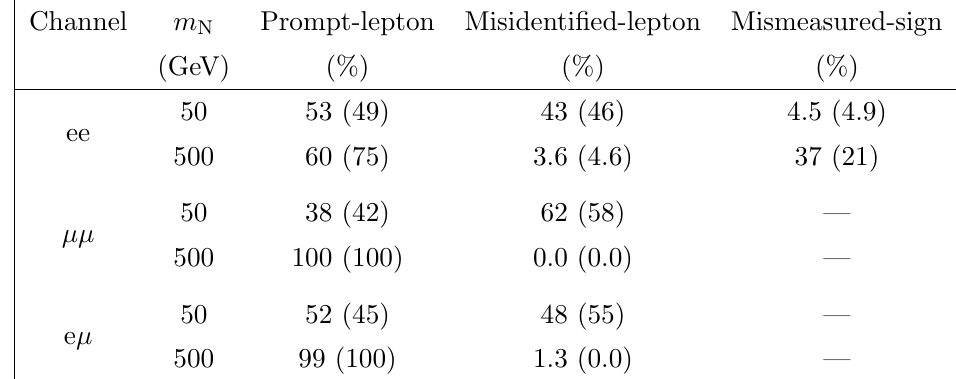
Table 3 . Fractional contributions to the total background systematic uncertainties related to the uncertainties in the prompt SS lepton, misidenti(cid:12)ed-lepton, and mismeasured-sign background. The numbers are for the SR1 (SR2) in the case of m N = 50 and 500 GeV.